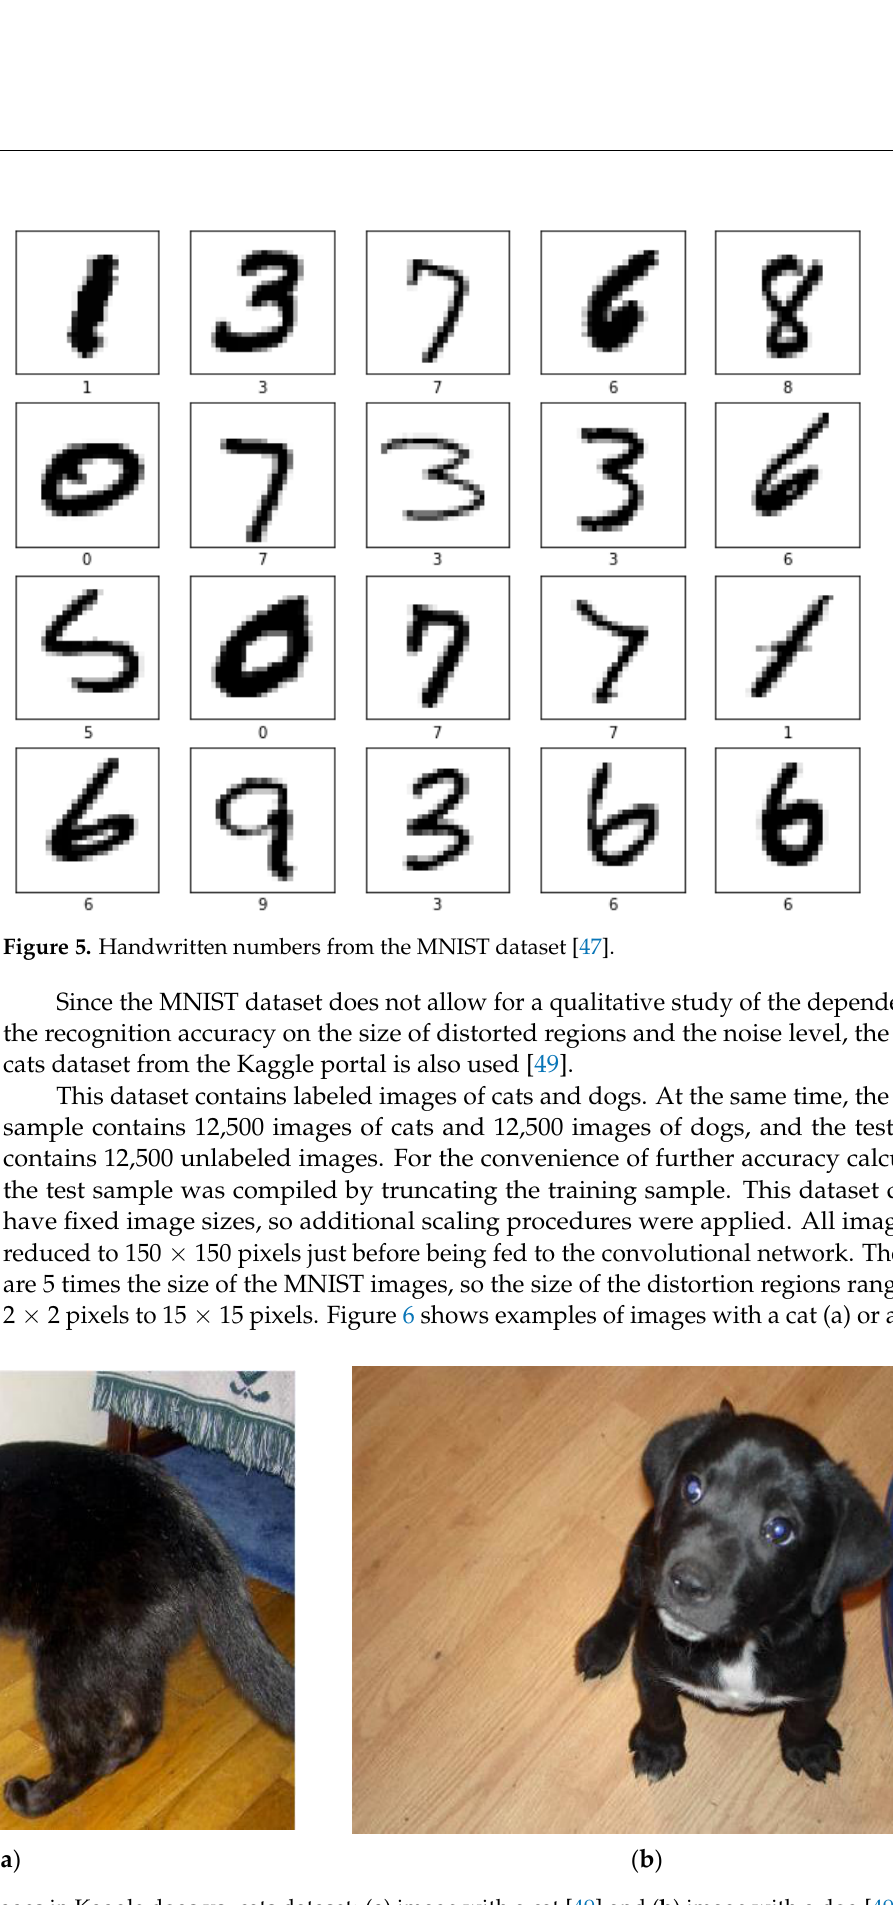
Figure 6. Examples of images in Kaggle dogs vs. cats dataset: ( a ) image with a cat [49] and ( b ) image with a dog [49].